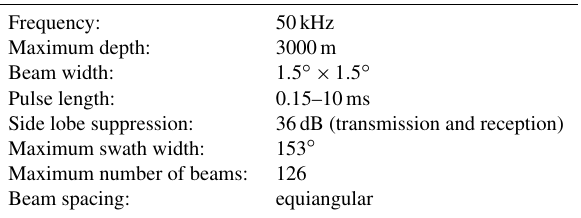
Table 1. Overview of the technical specifications of the Seabeam 1050.